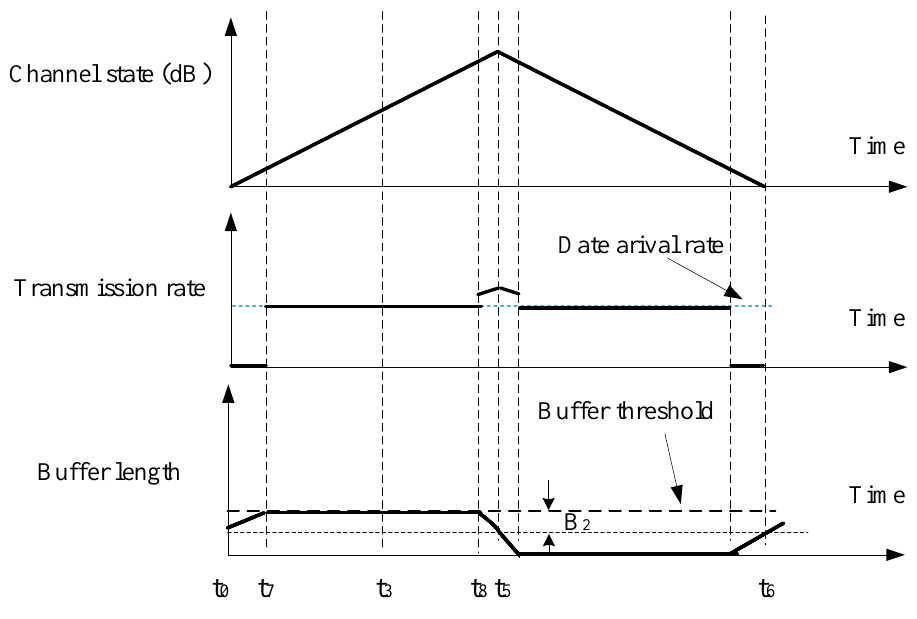
Figure 11. Transmission action when B c < 2 λ t 1 , for case 3.